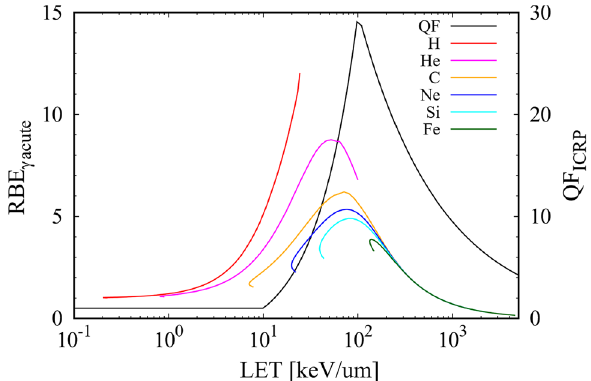
Figure 6. LET dependencies of biological scale parameters. RBE γacute (left axis) for simple exchanges to human peripheral blood lymphocytes 22 and QF ICRP (right axis) 15 .